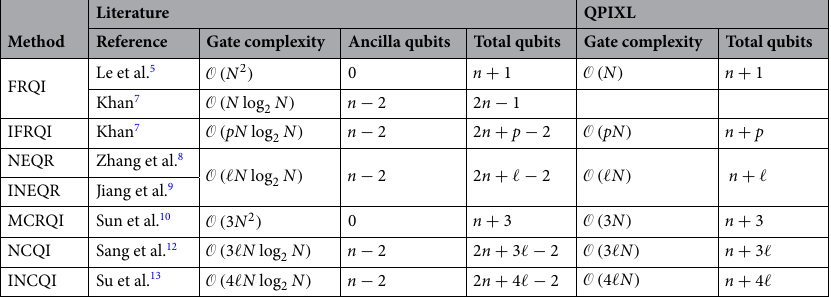
Table 2. Summary of gate complexities and qubit count for preparing the different QIR states covered in this 2 n pixels. For the IFRQI state, the bit depth is given by 2 p and for the paper and QPIXL for an image with N = (I)NEQR, MCRQI, and (I)NCQI states the bit depth is given by ℓ